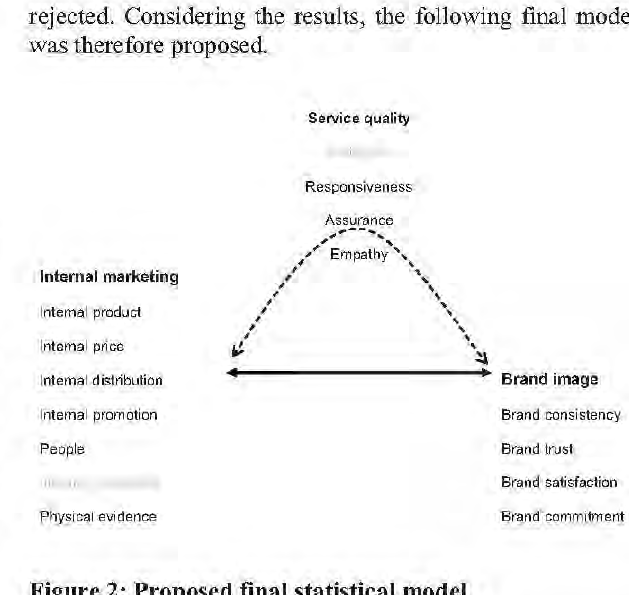
Figure 2: Proposed final statistical